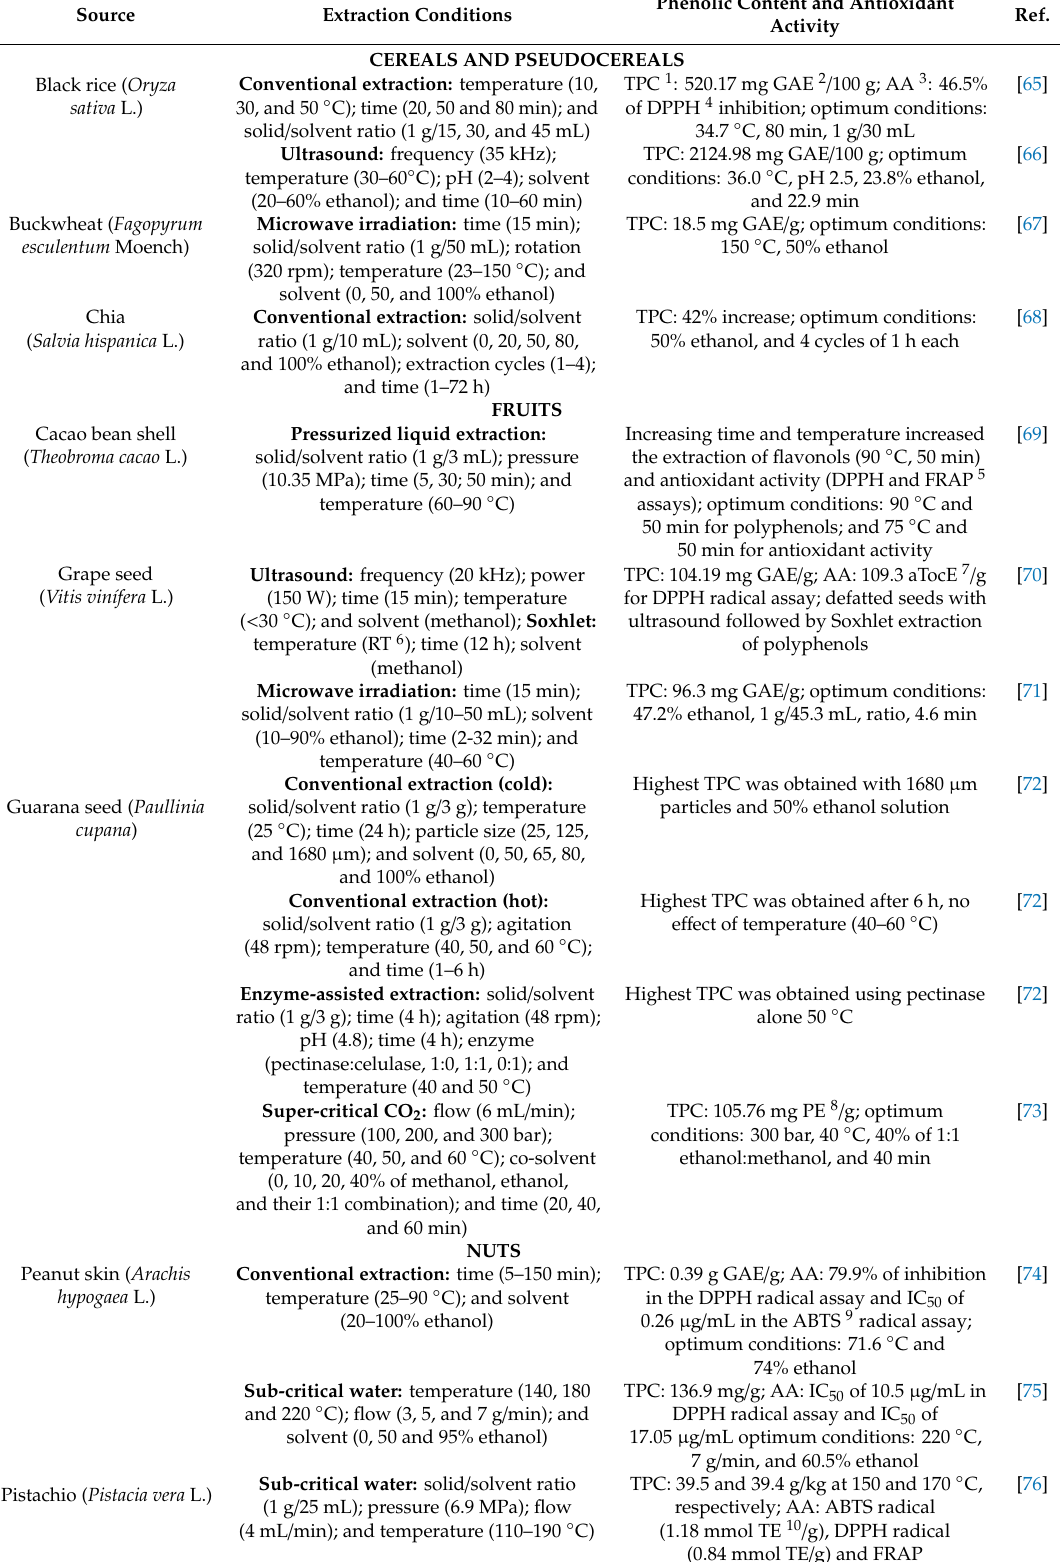
Table 2. Influence of extraction conditions in the phenolic content and antioxidant activity of seeds